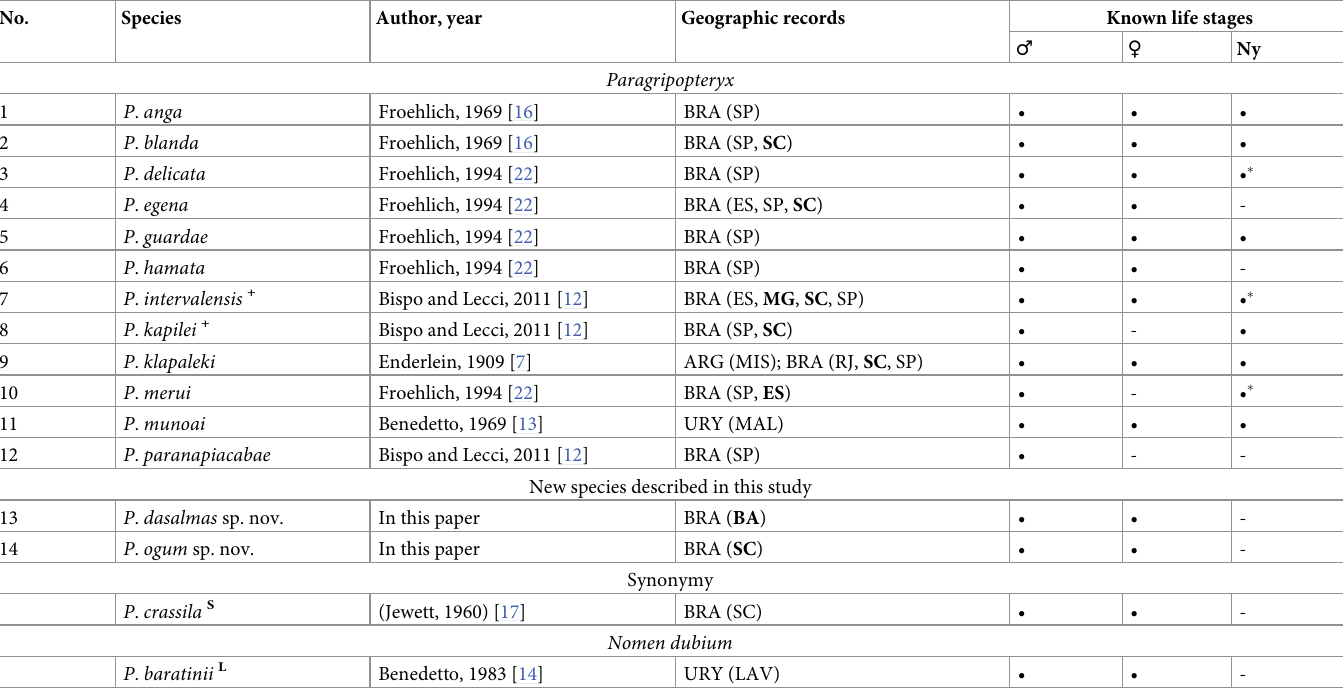
Table 2. Summary of the current taxonomic treatments of Paragripopteryx and their respective records and described stages (new geographic records in bold).